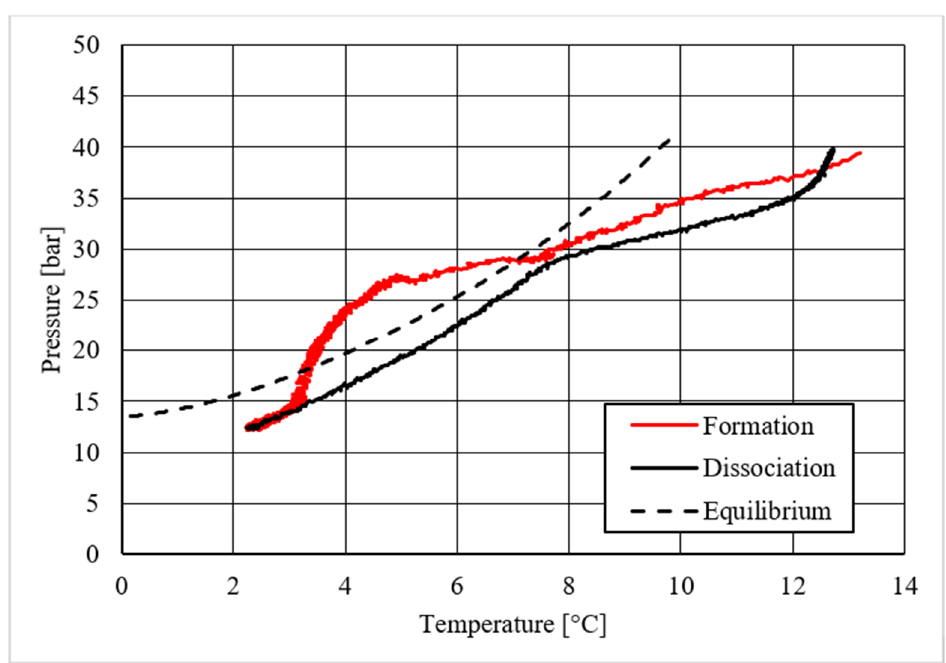
Figure 21. Pressure vs. temperature, describing carbon dioxide hydrate formation in the presence of 30.66 wt.% CuSn12 powder.